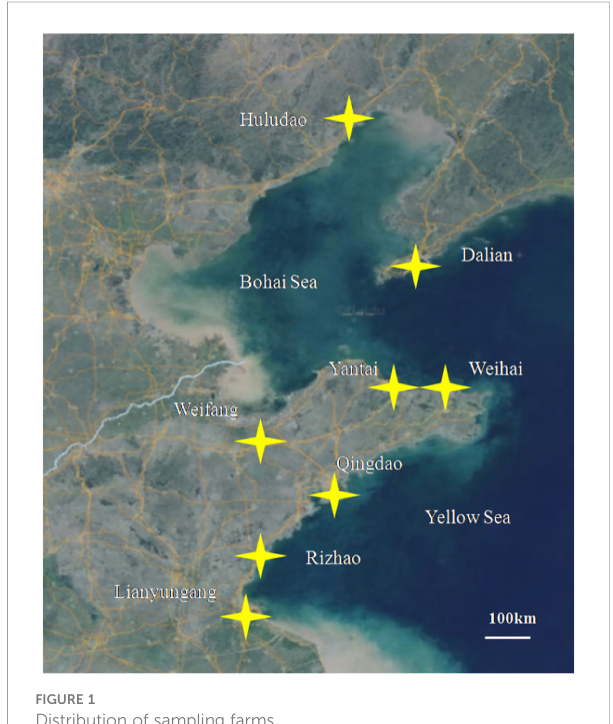
FIGURE 1 Distribution of sampling